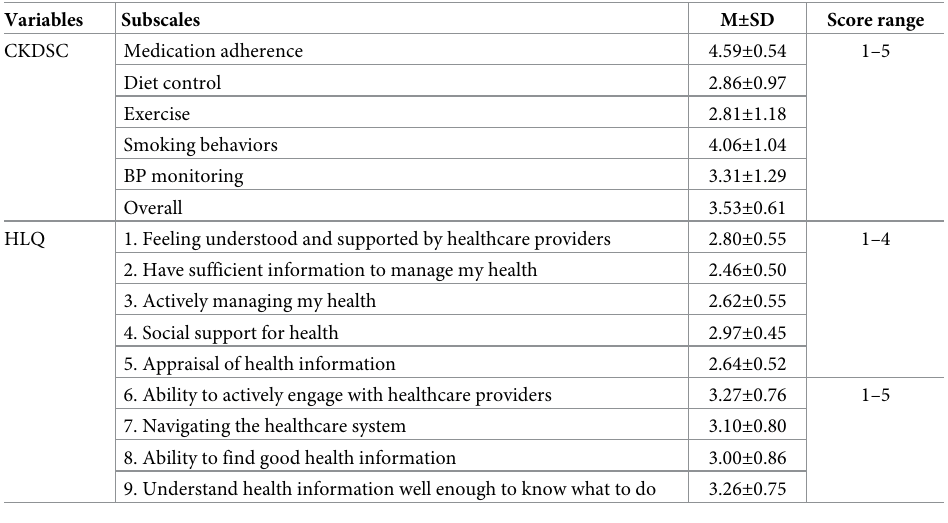
The results of the correlation analysis of the association between the nine scales of the HLQ and the CKDSC score are shown in Table 4. The correlation coefficient for the association between the CKDSC score and the score on scale 3 (“actively managing my health”) was the highest ( r = .46), and the correlation coefficient with the score on the scale 8 (“ability to find good information”) ( r = .16) was the lowest (Table 4). Table 2. CKDSC a and HLQ b scores (N =